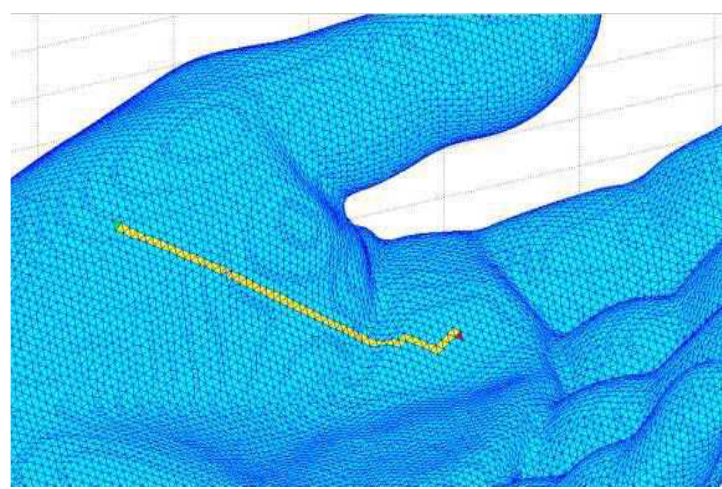
Figure 8. Triangle path.